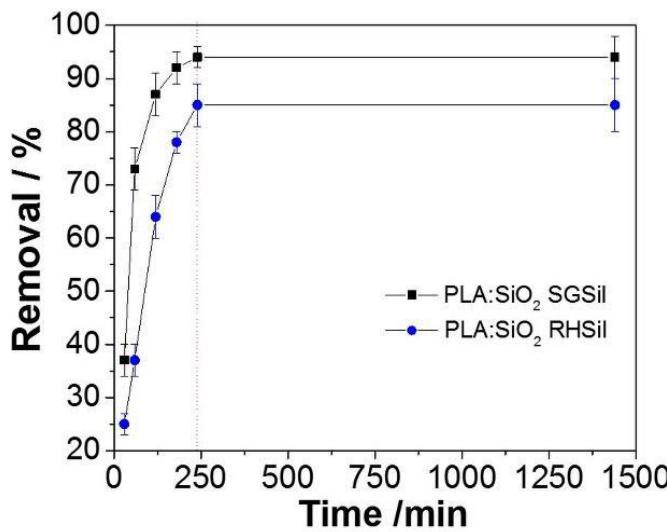
Figure 11. Kinetic study for RhB adsorption using PLA:SiO 2 nanocomposites.